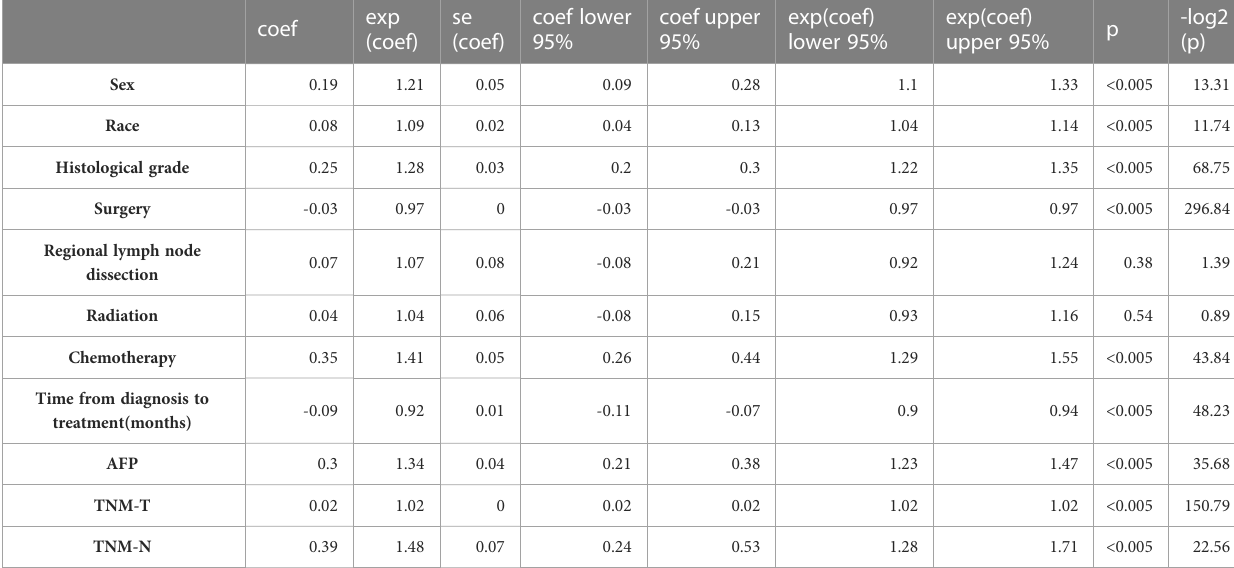
TABLE 2 Risk factors for